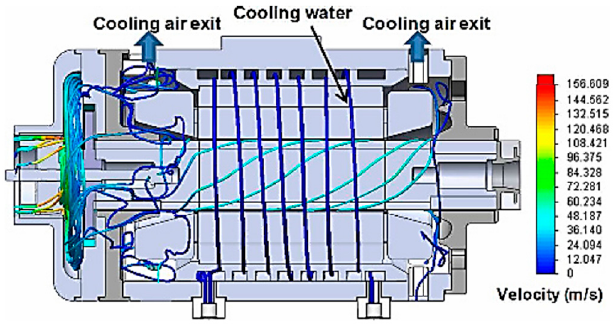
Figure 15. Cooling flow velocity distribution in PMSM at a rotor speed of 35 krpm [77].